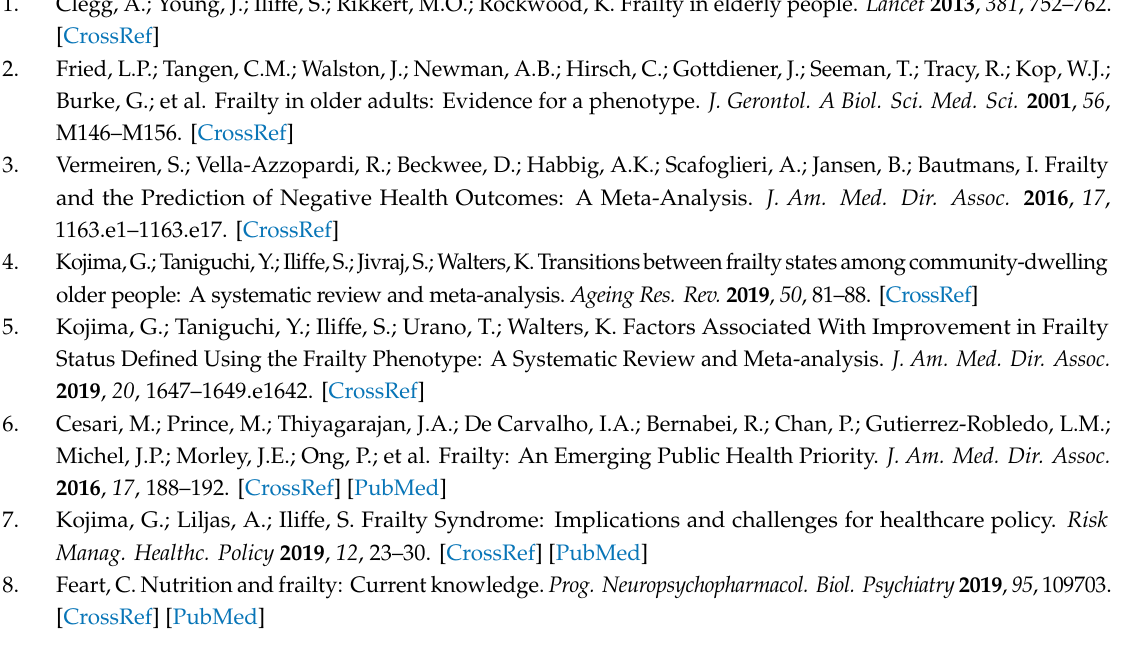
Figure S1: Self-completion questionnaires for fruit and vegetable consumption at English Longitudinal Study of Ageing wave 4 and conversion rates into